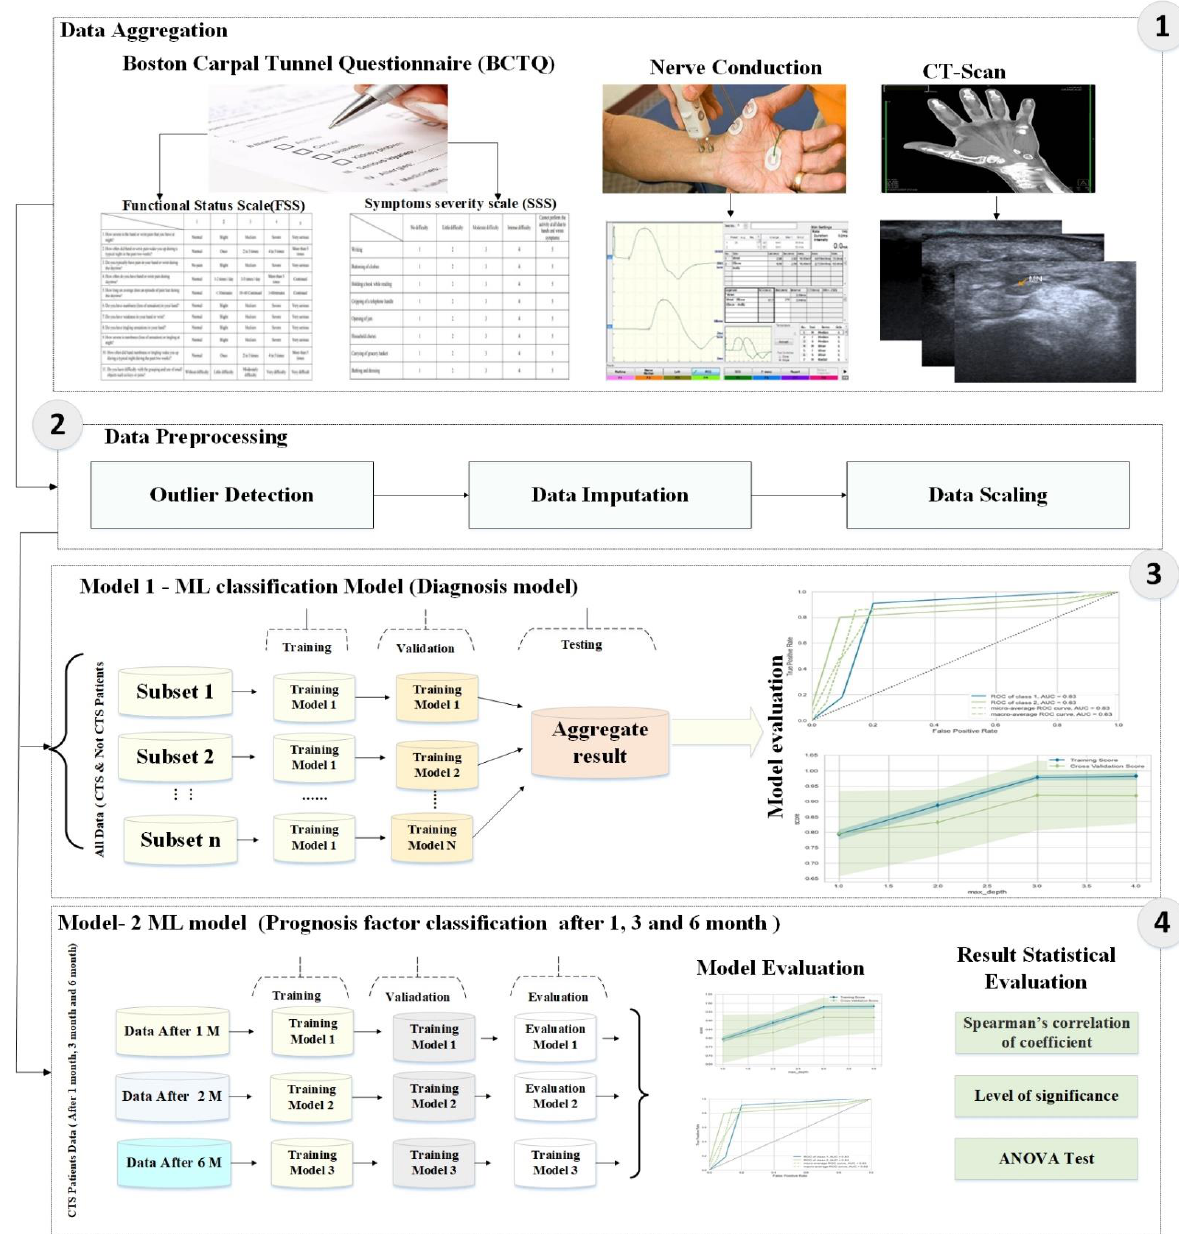
Figure 3. Proposed method architecture.